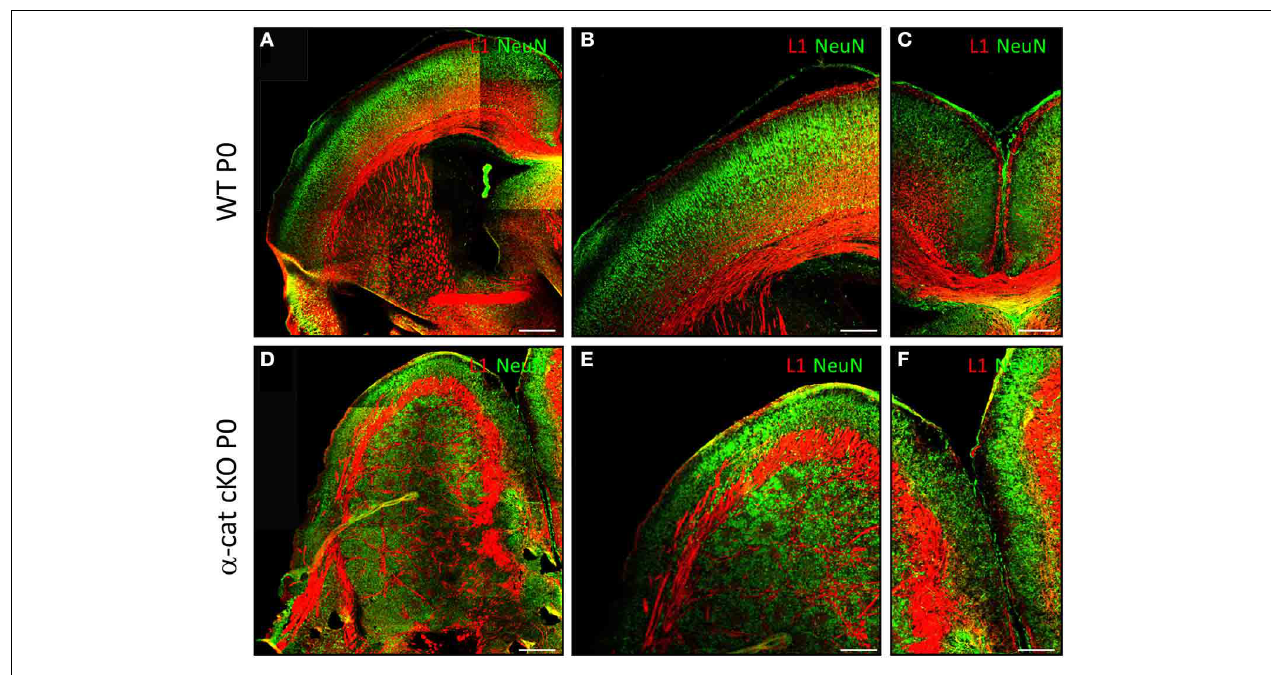
FIGURE 2 | Formation of SBH in the absence of α -E-catenin. Fluorescence micrographs of coronal cortical sections of P0 WT (A–C) and α -cat cKO (D–F) immunostained as indicated. (A,B,D,E) : lateral